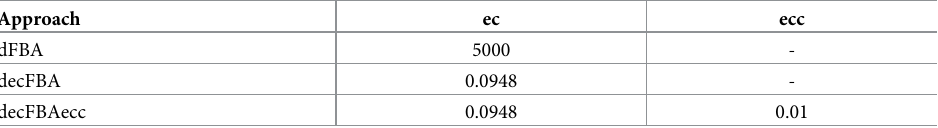
Table 2. Iterative change in constraints from dFBA to decFBAecc. The parameters that are subject to change are the total fraction of mass available for enzymes (ec; g gCDW − 1 ) and the amount of enzyme in terms of total mass that can be replaced per hour (ecc; g gCDW − 1 h − 1